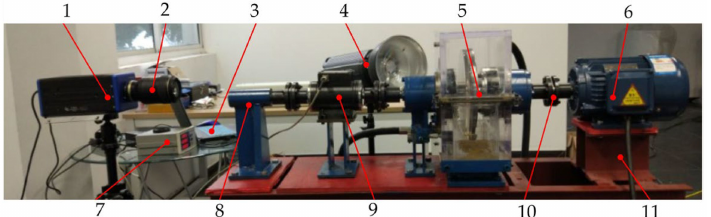
Figure 31. Transparent test platform (1 = high-speed camera; 2 = lens; 3 = computer; 4 = fill light; 5 = host; 6 = motor; 7 = data collection unit; 8 = magnet powder brake; 9 = torque sensor; 10 = coupling; 11 =